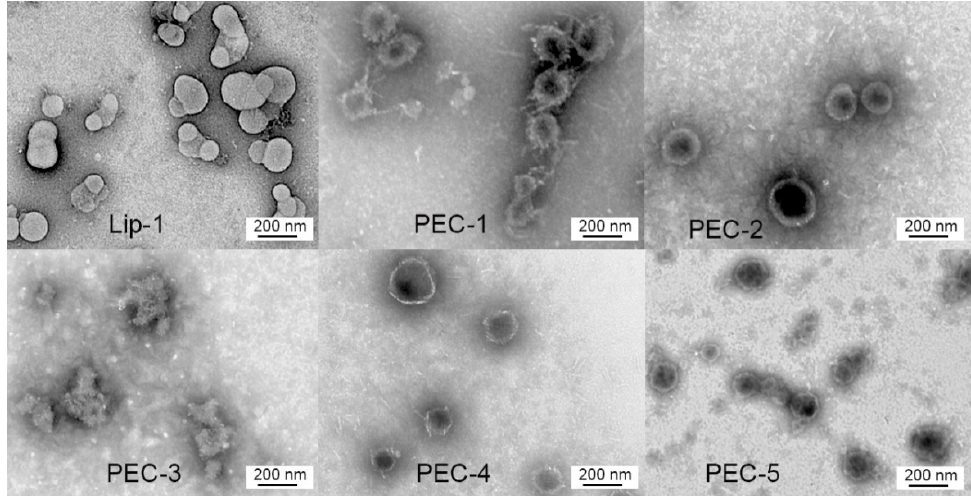
Figure 2. Transmission electron microscope images of LCP-1 loaded nanoparticles, including Lip-1, PEC-1 to PEC-5.